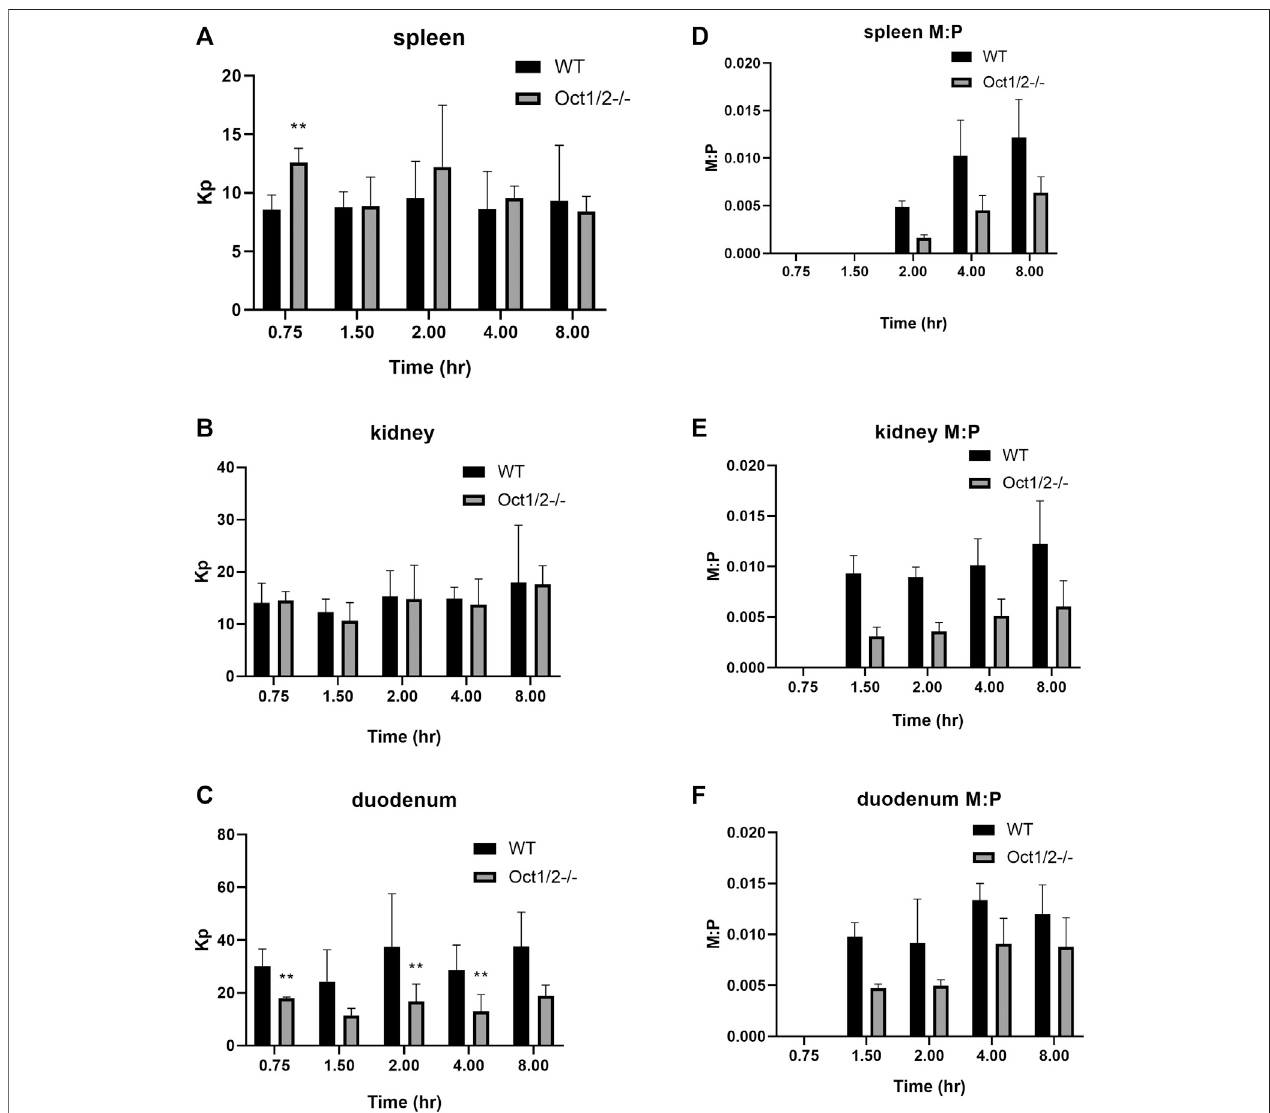
FIGURE 5 | Partitioning of proguanil (A and B, C) and cycloguanil metabolite:parent ratio (D and E, F) in tissues other than liver in wildtype (WT) and Oct1/2 − / − micefollowingIVadministrationofproguanil. Mice( n (cid:2) 5/timepoint)wereadministeredproguanil2,10or30 mg/kgandtissuescollectedat0.75and2 h (2 mg/kg), 1.5 and 4 h (10 mg/kg) or 8 h (30 mg/kg) post-dose. Data presented as mean ± SD. ** p < 0.01 using student ’ s t-test, compared to WT. Kp (cid:2) tissue:plasma partition coef fi cient. M:P (cid:2) metabolite:parent ratio.